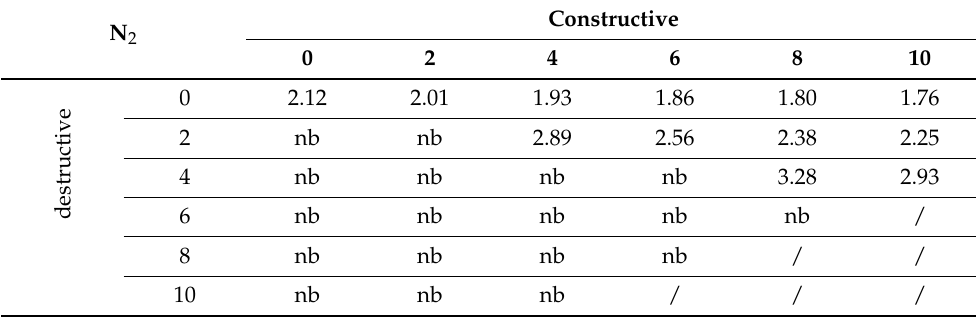
Table 1. Equilibrium bond distances for N 2 from OF-DFT approaches, including various amounts of constructive versus destructive interactions between the atoms. According to molecular orbital (MO), theory N 2 exhibits eight constructive and two destructive interaction terms. The corresponding entry is indicated in bold. The equilibrium bond distance for the bare atomic fragment approach was already published elsewhere